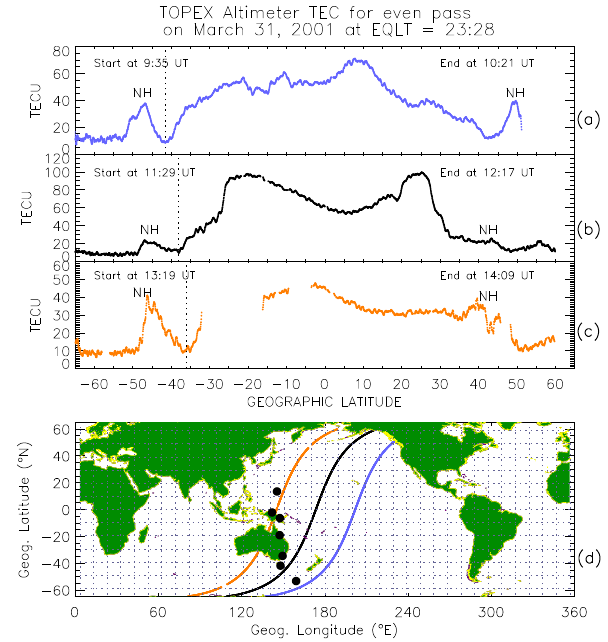
Fig. 5. ( a ) − ( c ) The TEC derived from the TOPEX altimeter, taken from an altitude of ∼ 1335km near a local time of 23:30 LT. ( d ) The corresponding (identified by a colour code) TOPEX ground